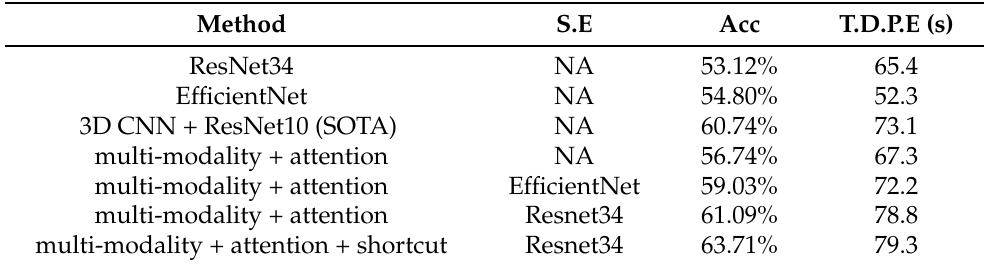
Table 3. Performance of different models. Abbreviations: separable embedding (S.E.), training duration per epoch